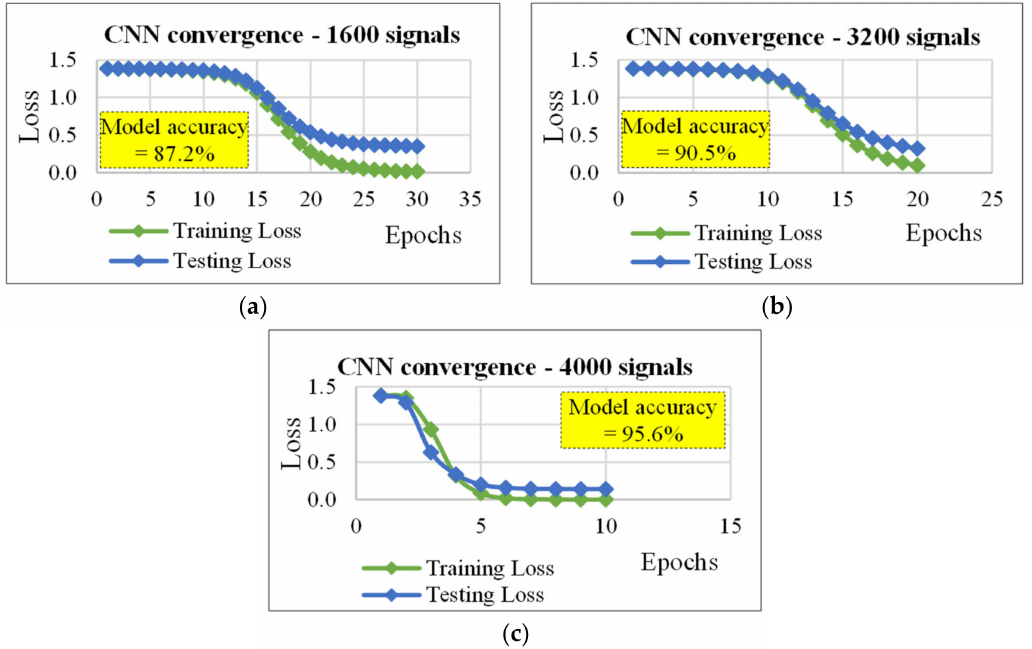
Figure 7. Convergence plots for the CNN (cf. Table 3, section “number of optimization filters”): ( a ) data set size (D) = 1600 signals, ( b ) D = 3200 signals, and ( c ) D = 4000